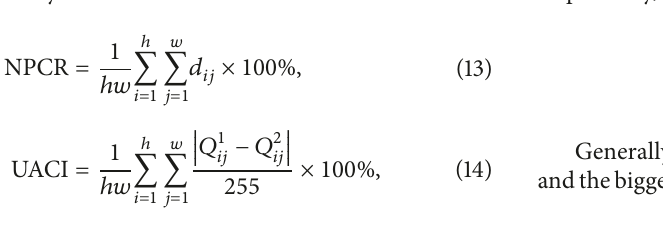
two cipher images 𝑄 1 and 𝑄 2 can be formulated as (13) and (14),